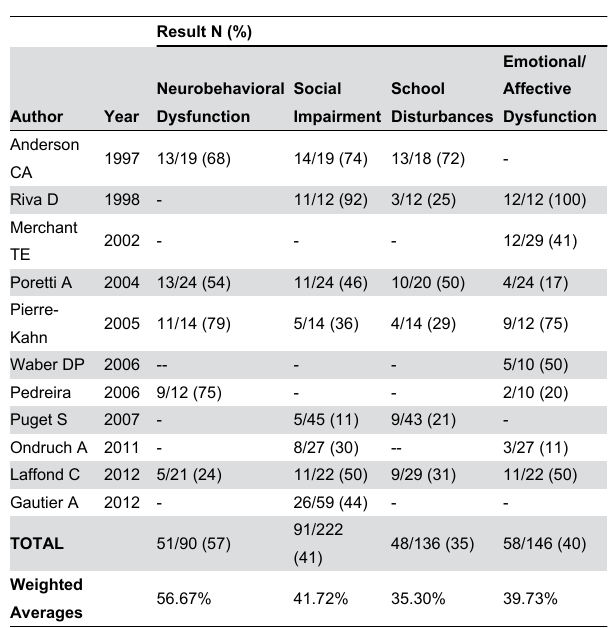
Table 3. Proportions and cumulative weighted averages of neurobehavioral, social, school, and emotional/affective dysfunction derived from 11 studies with relevant